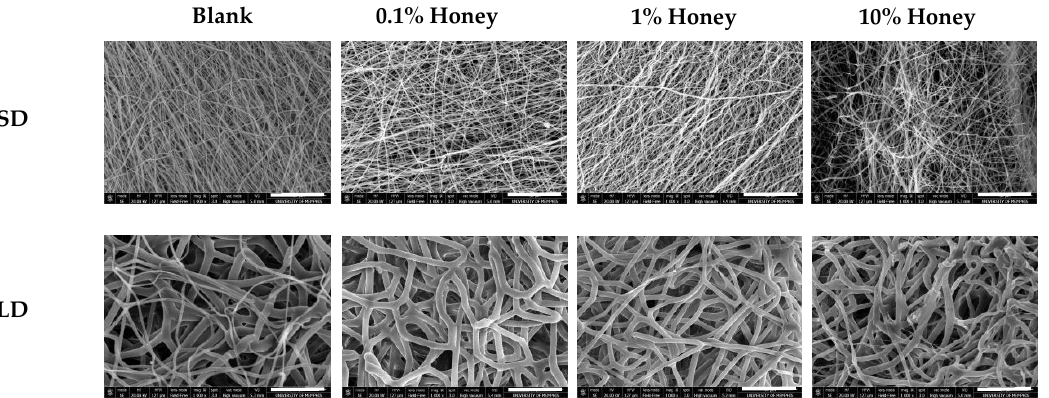
Figure 1. Low and high polymer concentrations create small diameter (SD) and large diameter (LD) fibers. SEM images of each template type. Scale bars = 30 µm. Table 3. Fiber diameters and pore diameters of each template type (mean ± standard deviation). * indicates a significant difference between the pore diameters of the LD and SD templates at each honey condition. # indicates a significant difference from the non-honey blank with the corresponding fiber size (SD or LD). Three images of each template type were analyzed with a minimum of 200 fiber diameter measurements and 60 pore diameter measurements taken per image. Raw data is available in Supplementary Spreadsheet 1.